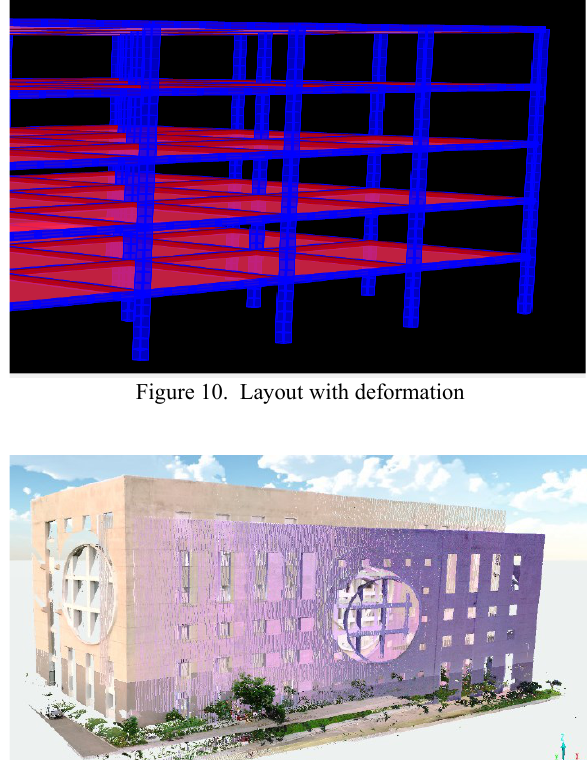
Figure 11. 3D point cloud RGIPT Academic building 2